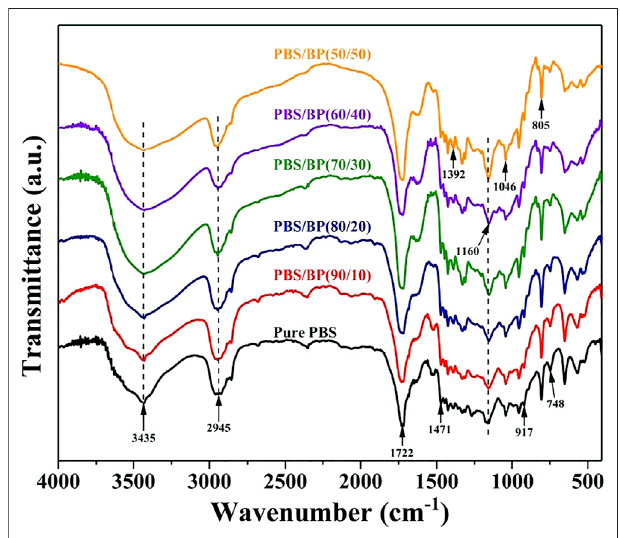
FIGURE 1 | FTIR spectra of the pure PBS and PBS/BP blends at varied